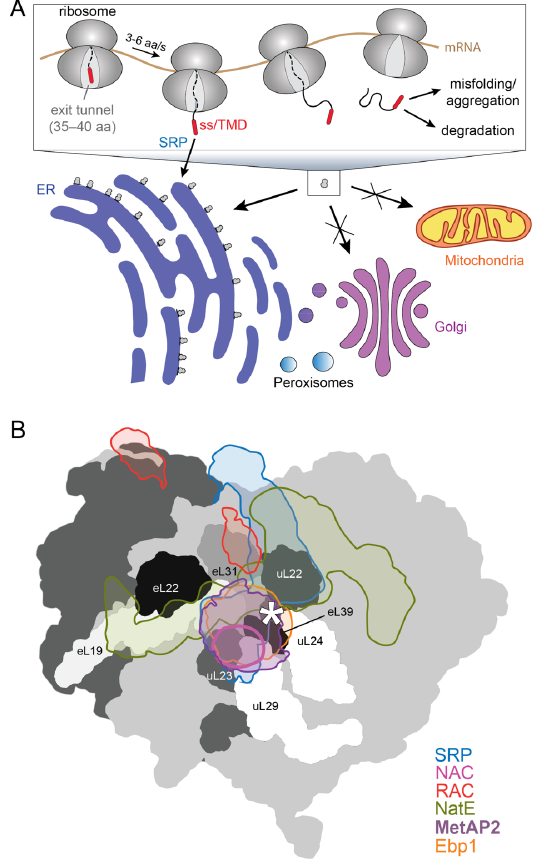
Figure 1. Overview of cotranslational ER targeting and ribosome-associated protein biogenesis factors (RPBs). ( A ) Overview of cotranslational protein targeting in eukaryotic cells. Proteins destined to the endomembrane system are initially targeted to the ER during translation, based on recognition of highly hydrophobic signal sequences (SS) or TMDs on the nascent chain by the SRP pathway. Cotranslational protein targeting is likely in kinetic competition with translation elongation, and failure to complete the targeting reaction within the duration of protein synthesis can lead to the misfolding, aggregation and downstream degradation of nascent secretory and membrane proteins. ( B ) Overlay of known RPB structures onto the surface facing the nascent polypeptide exit site (marked by ‘*’) of the 80S eukaryotic ribosome (PDB-4UG0; light grey and dark grey indicate the 60S and 40S subunits, respectively). Electron densities of ribosomes bound with SRP (EMD-3037), NatE (EMD- 4745), NAC (EMD-4938), RAC (EMD-6105), Ebp1 (EMDB-10321), or MetAP2 (PDB-1BN5) are aligned according to the 60S density. The density of MetAP2 is derived from homology modeling with Arx1-ribosome structure (PDB-5APN). The densities of RAC and NAC contain only part of the complex due to low resolution of the EM density map. The silhouettes of the individual RPBs are shown in the indicated colors. Ribosomal proteins in the vicinity of the tunnel exit are colored in different shades of grey and indicated following the nomenclature proposed in Ban et al. [10], with ‘L’ indicating the large ribosomal subunit, ‘u’ indicating universally conserved ribosomal proteins, and ‘e’ indicating eukaryote-specific ribosomal protein